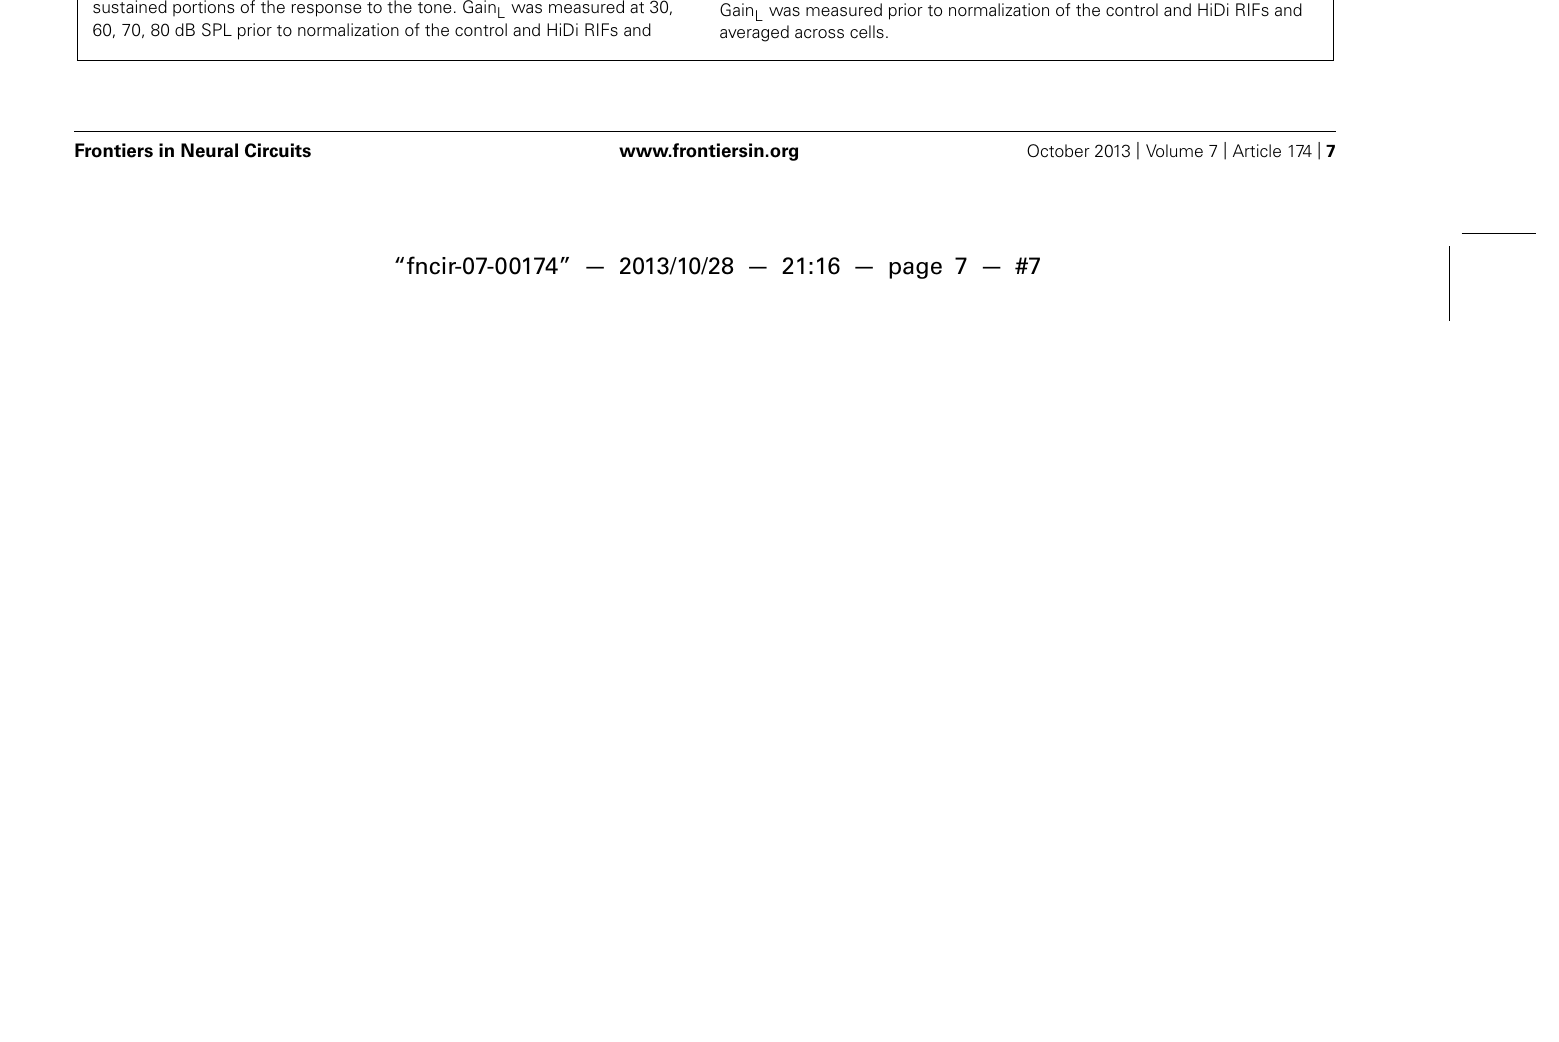
FIGURE 4 |Temporal activation of monosynaptic and local inputs. For both intensity-variant and tuned neurons, onset responses are averaged over the first 20 ms; sustained responses are averaged between 25 and 100 ms. Response onsets are measured from the mean first spike latency. RIFs are normalized. All data are from cells that exhibited a sustained response during a 100 ms tone. (A,B) Intensity-variant neurons. (A) Onset and sustained responses in control (top) and HiDi (bottom) for five cells with dynamic ranges > 60 dB. (B) Population averages.Twelve cells. Mean and SD.The RIF due to the monosynaptic input has a short dynamic range during both the onset and sustained portions of the response to the tone. Gain L was measured at 30, 60, 70, 80 dB SPL prior to normalization of the control and HiDi RIFs and